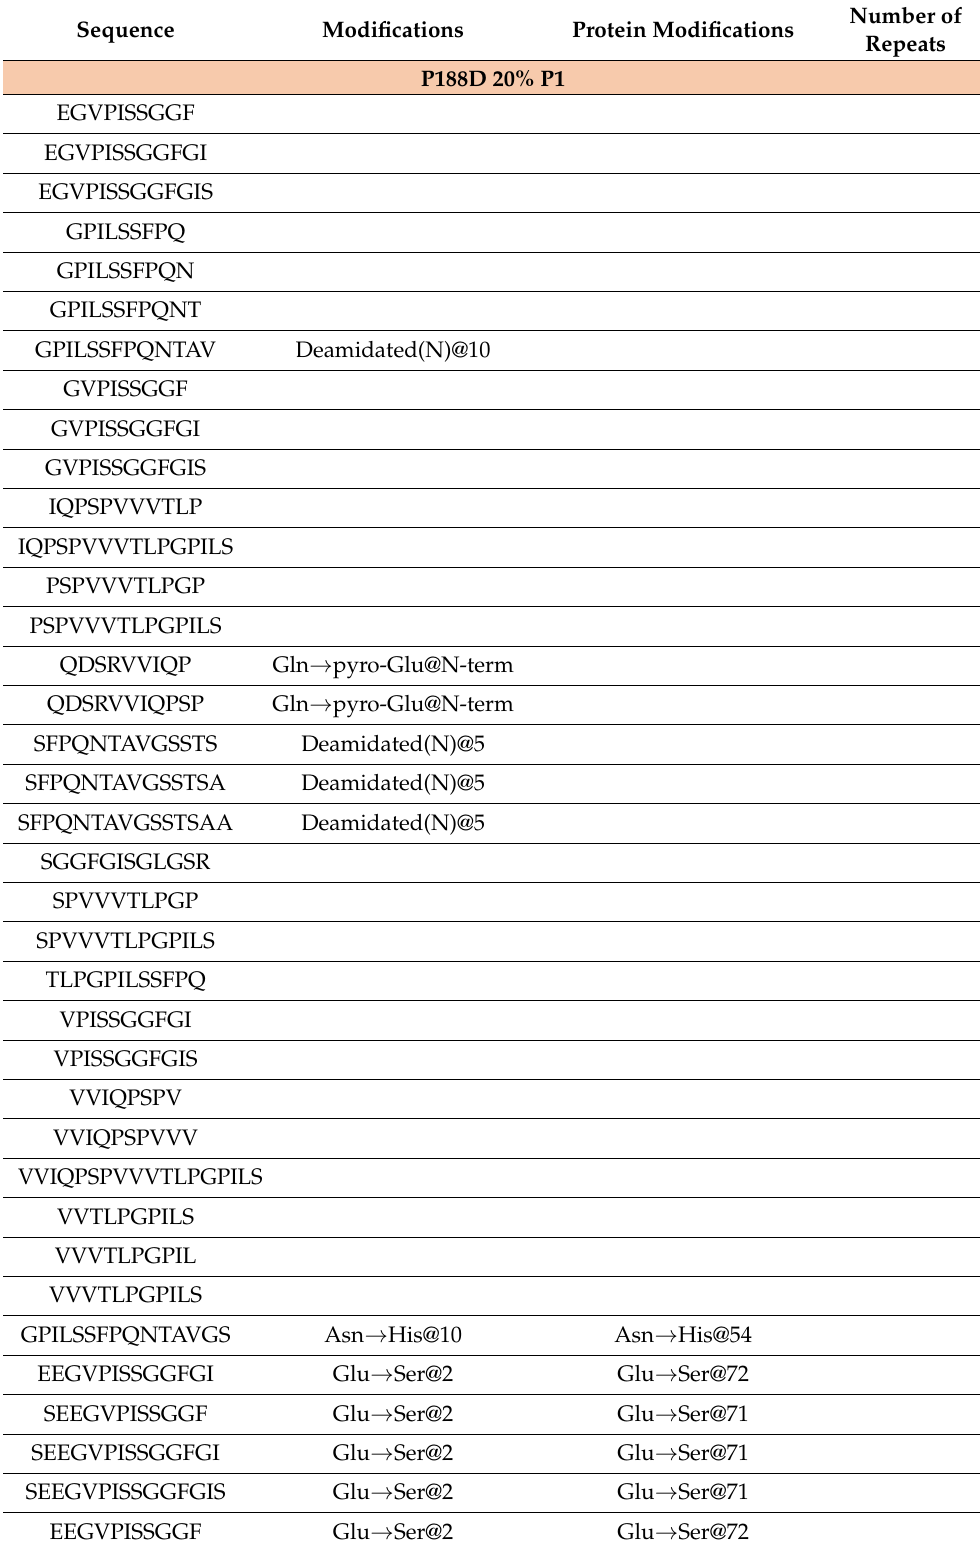
Table 5. Peptide sequence of the chicken feather microbial degradation present in the fraction P188D 20% P1, P2 and P3 with 99% of confidence and its homology to chicken feather keratin 4, 1, 3,